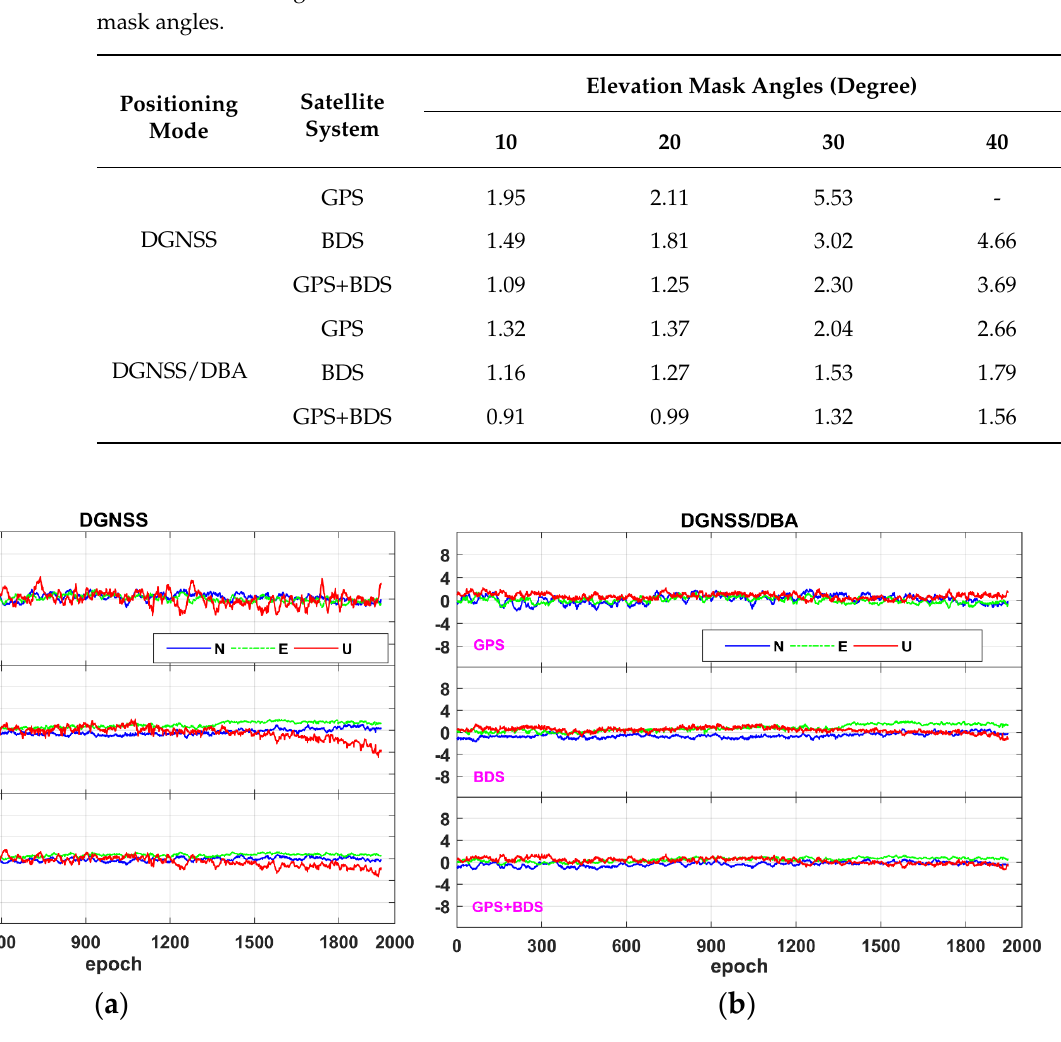
( b ) Figure 6. The deviation sequence diagram in the N/E/U directions at 20 − degree elevation mask an- gles: ( a ) DGNSS positioning mode; ( b ) DGNSS/DBA positioning modes